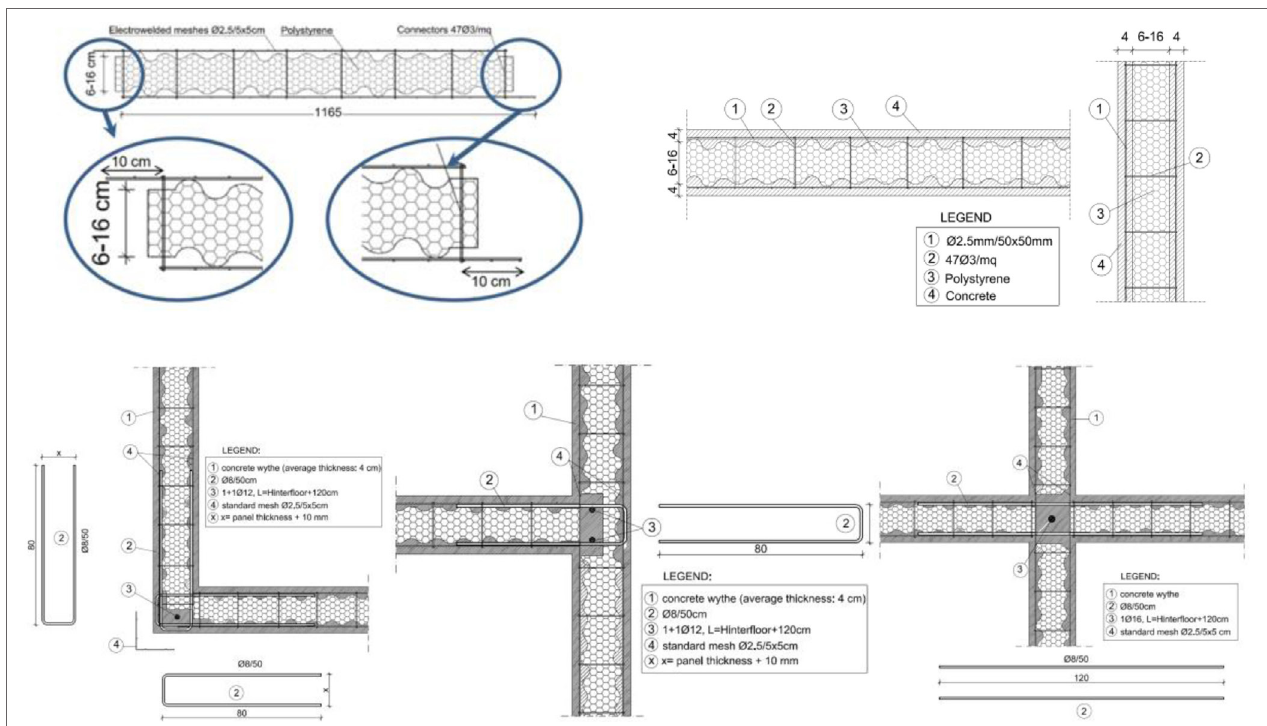
FigURe 10 | Top: typical dimensions of the sandwich panel (Palermo and Trombetti, 2016). Bottom: typical connections between orthogonal panels (Palermo and Trombetti,